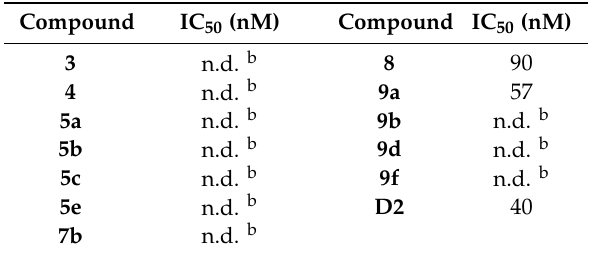
Table 1. Antiproliferative activity of bis-benzamides a